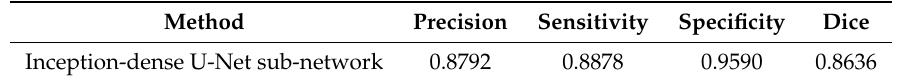
Figure 14. The results of detecting parenchyma regions, nodule candidates and determining nodules by the proposed cascaded network on five different chest CT images. Table 5. Quantitative results of detecting parenchyma regions from input chest CT images by the proposed network.